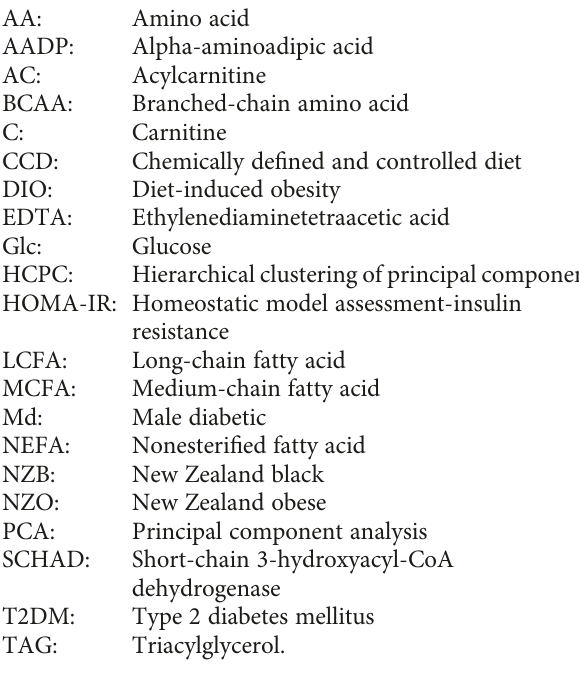
Supplementary 1 . Supplemental Table A.1: descending order from highly positively related to highly negatively related plasma metabolites for clusters 1, 2, and 3 based on Figure 1. Supplementary 2 . Supplemental Table A.2: ANOVA test results and fold changes from plasma-derived phenotypic traits including blood glucose, insulin, TAG, NEFA, and urea to reveal di ff erences among diabetic male NZO mice (Md) and non-/prediabetic male NZO mice